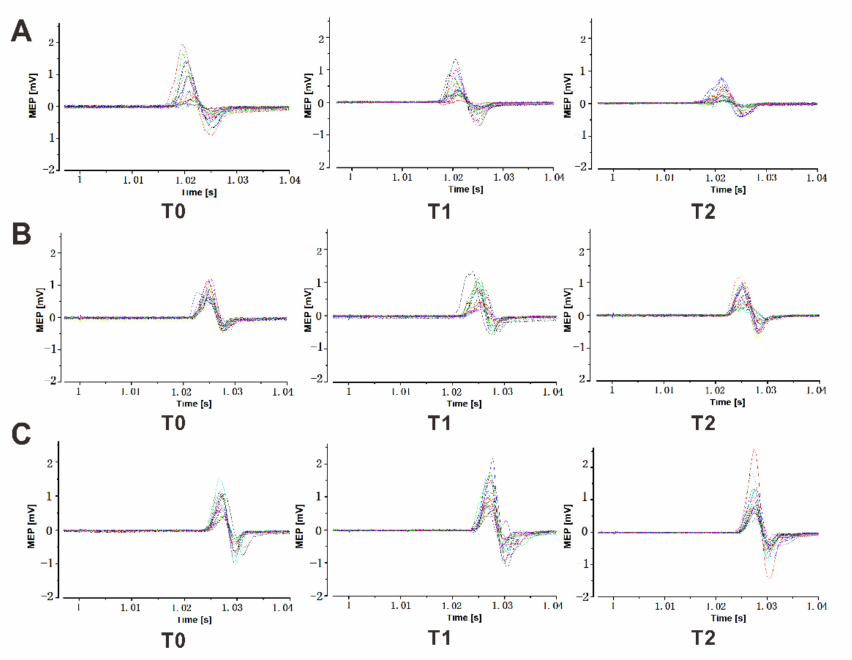
Figure 3. Raw electromyographic data traces from a representative individual showing motor-evoked potentials (MEPs). MEPs evoked by TMS over the left motor cortex in the 20 Hz tACS ( A ), 10